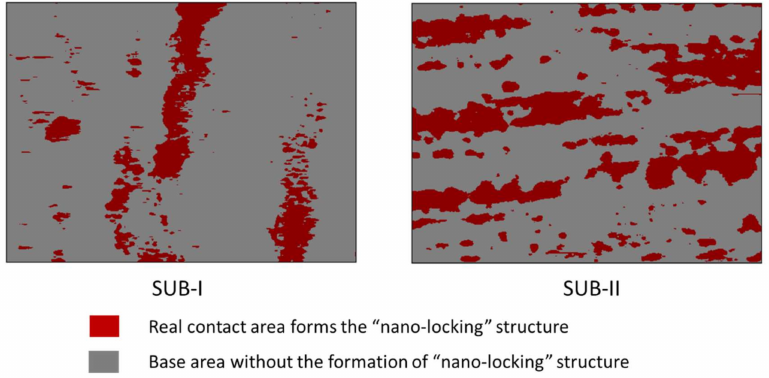
Figure 5. Real contact area distribution on the metallic pads of the two different types of package substrates under the same